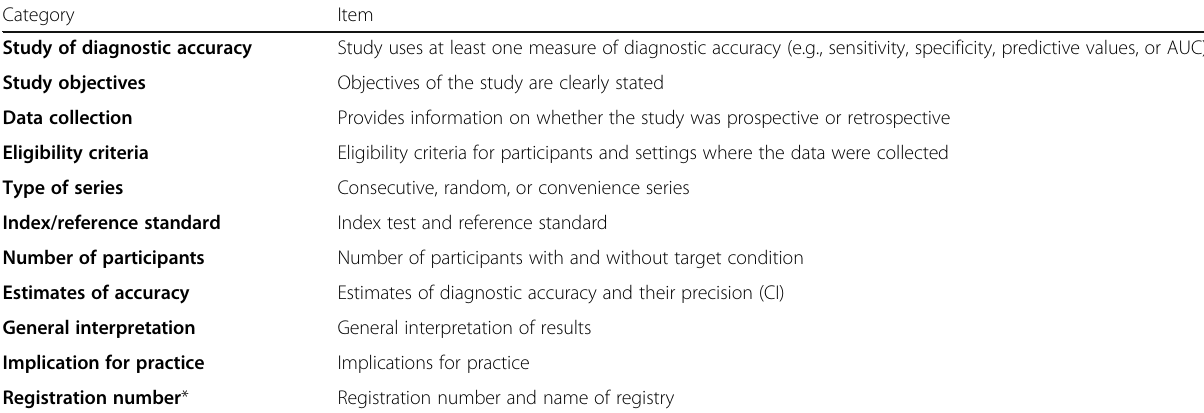
Table 1 STARD criteria for abstracts (adapted from Cohen et al.